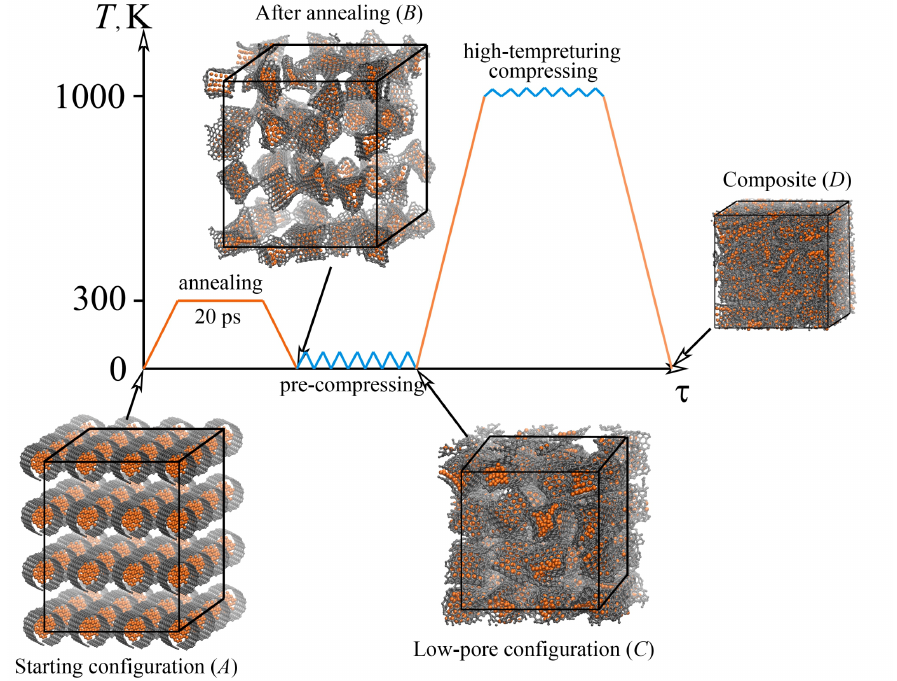
Figure 1. Scheme of the performed tests and their corresponding conditions to obtain a Ni/graphene composite. Snapshots of the structures in the initial ( A ), final ( D ) states, and states after each processing stage (stage B , after annealing at 300 K for 20 ps; stage C , after pre-compression). Nickel atoms are shown by orange and Carbon atoms, - by grey